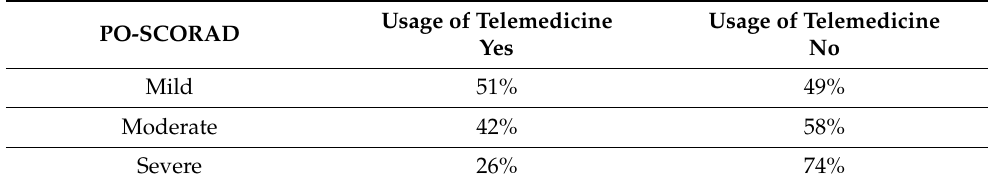
Table 3. Usage of telemedicine during COVID-19.